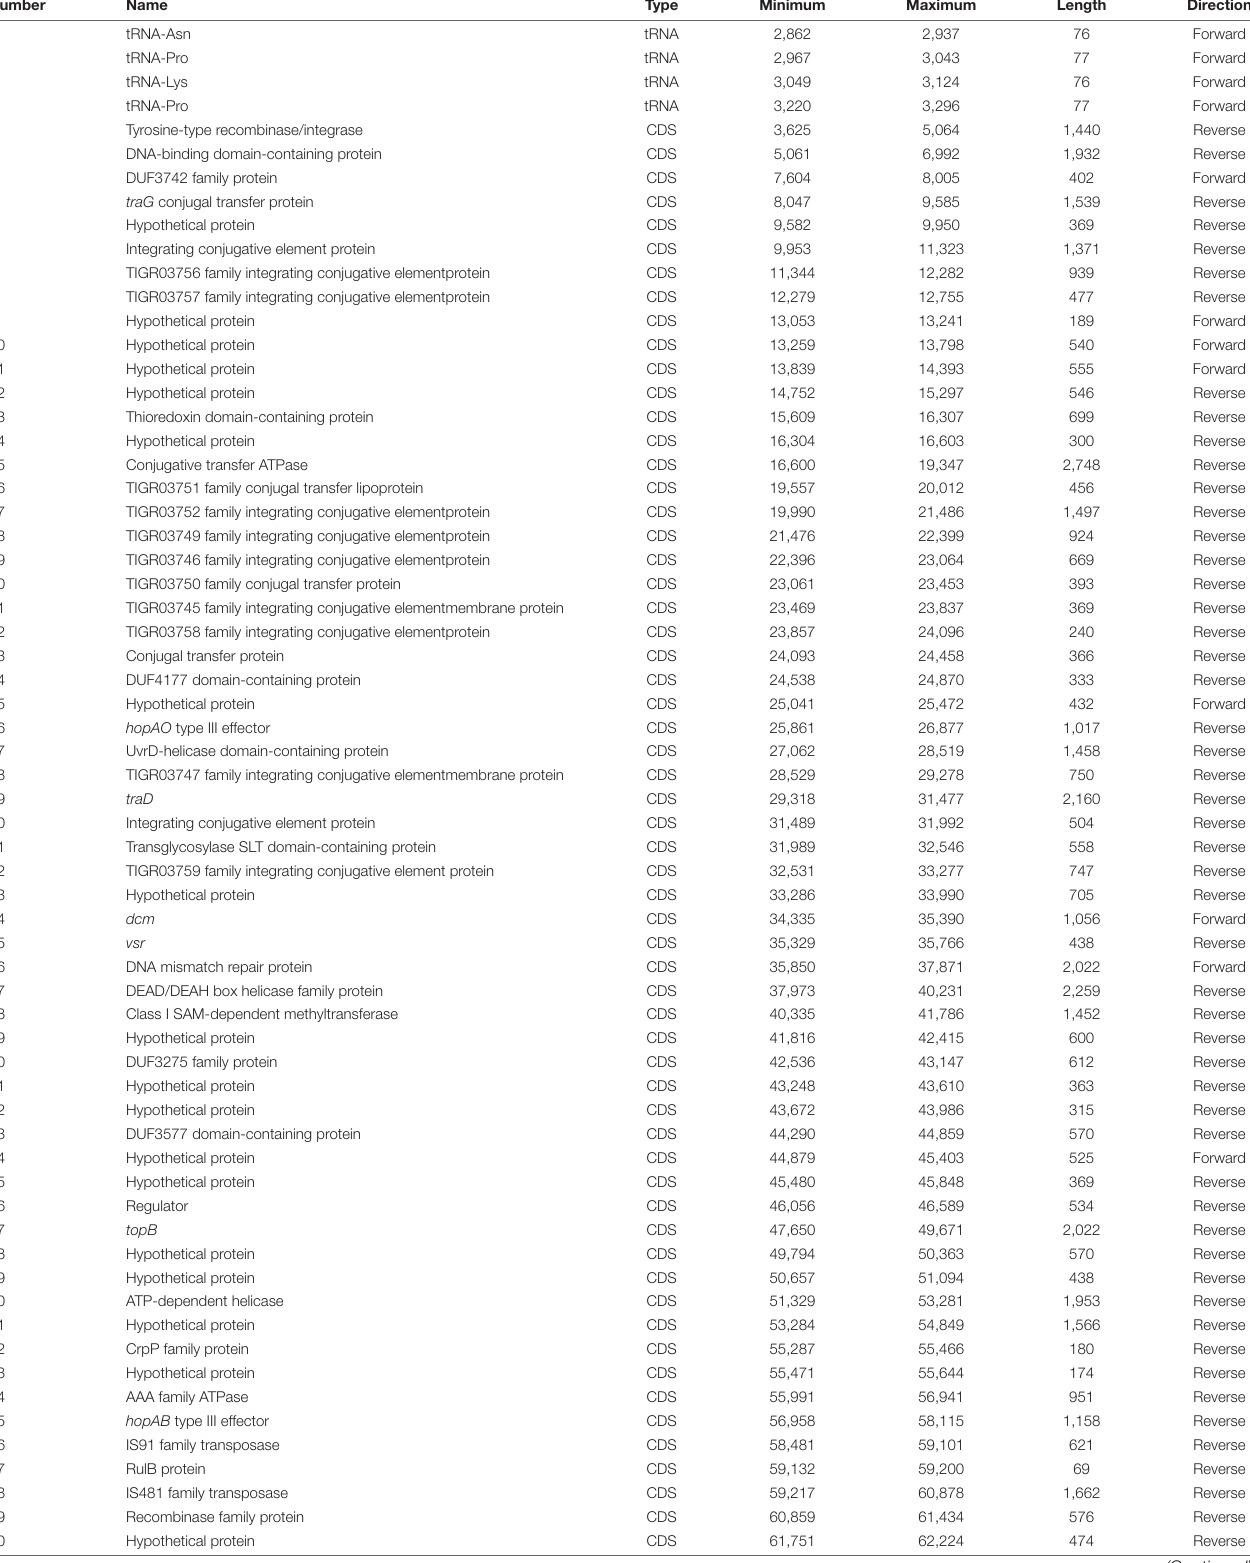
TABLE 3 | Gene annotations in Pma ES4326